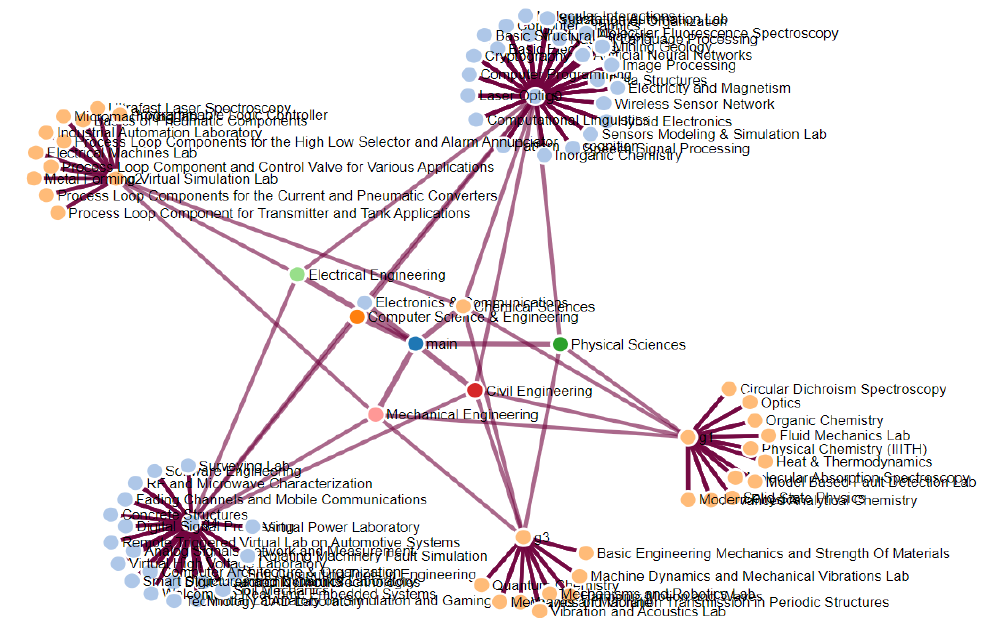
Figure 3. Clustering Results with K-Means Algorithm.